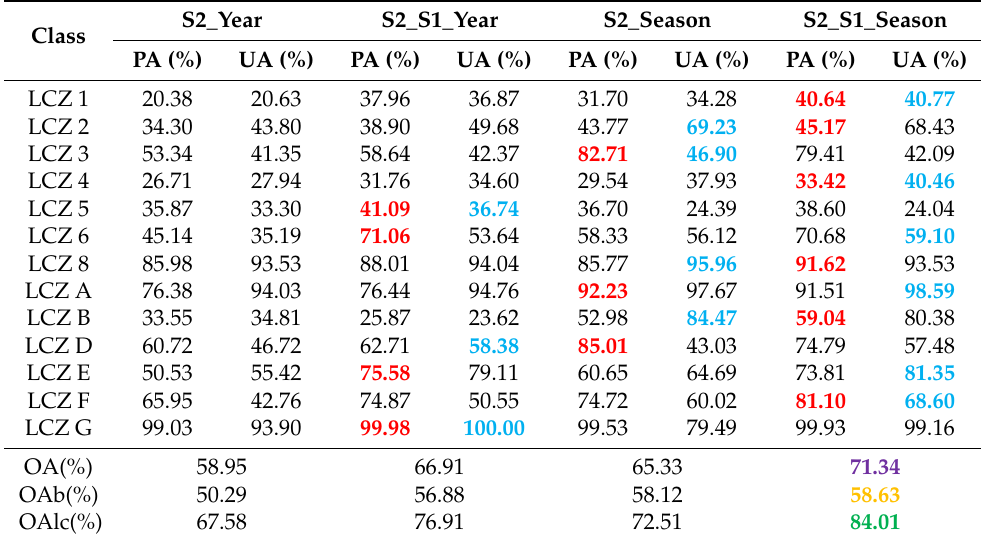
Table 5. The accuracy comparison of Sentinel-2 data and Sentinel-1 data.